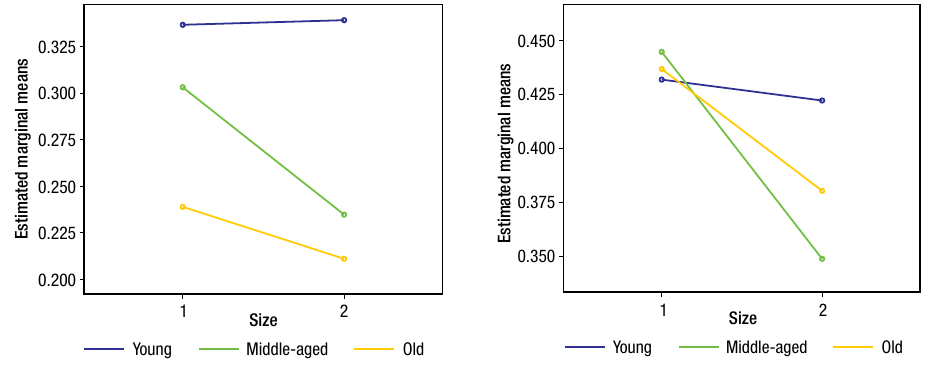
Fig. 4. TRADE CREDIT Variable Fig. 5. RELATIVE TRADE CREDIT